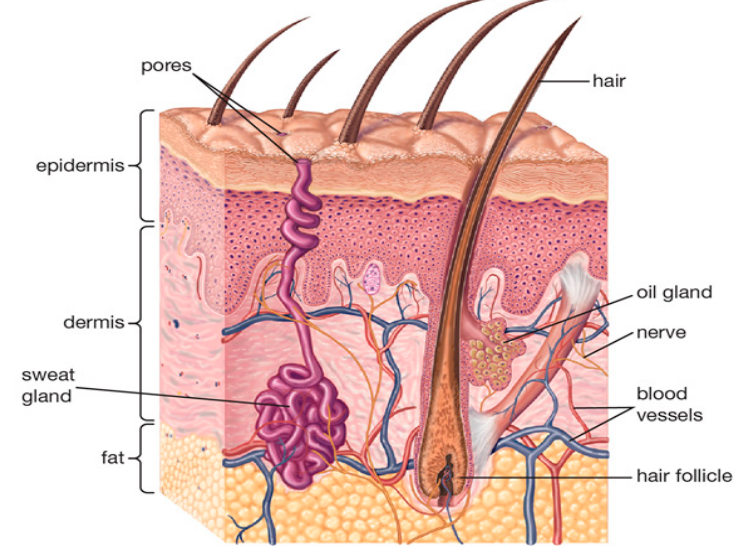
Figure 1. Schematic for human skin structure [38]. Radiation in the lower frequency portion of the MMW band penetrates down into the dermis. The schematic obtained from [38] an open access encyclopædia (Encyclopædia Britannica).